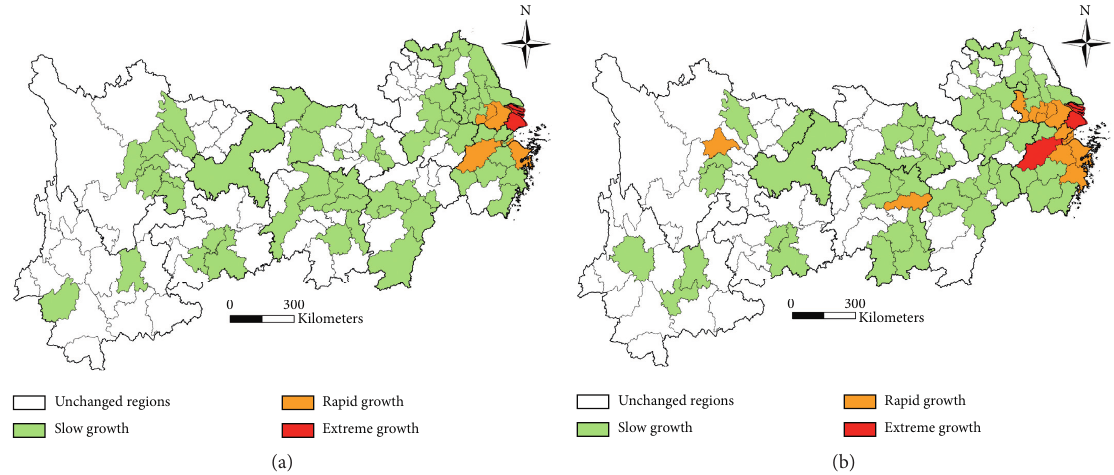
Figure 6: The classification of quantity growth trend of listed companies in the YEB region for (a) 2008 and (b) 2017. Table 1: Global Moran’s I index of spatial agglomeration of listed companies in the YEB region. 2008